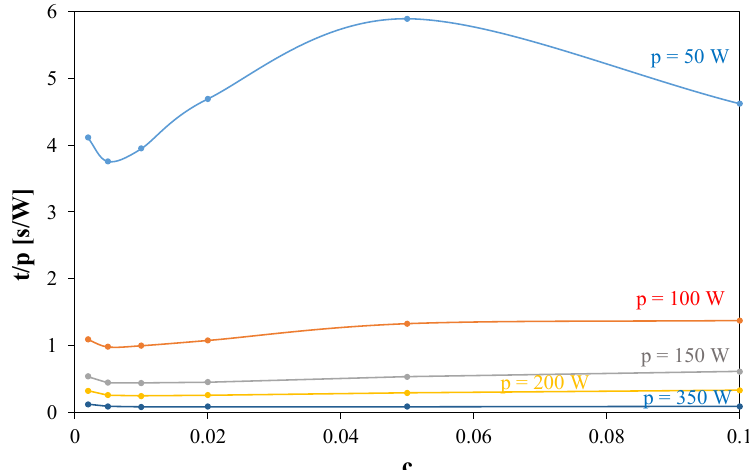
Figure 7. Calculated and measured dependence of the time ratio t by power p on the electrolyte concentration for selected values of power p dissipated in the electrolyzer.